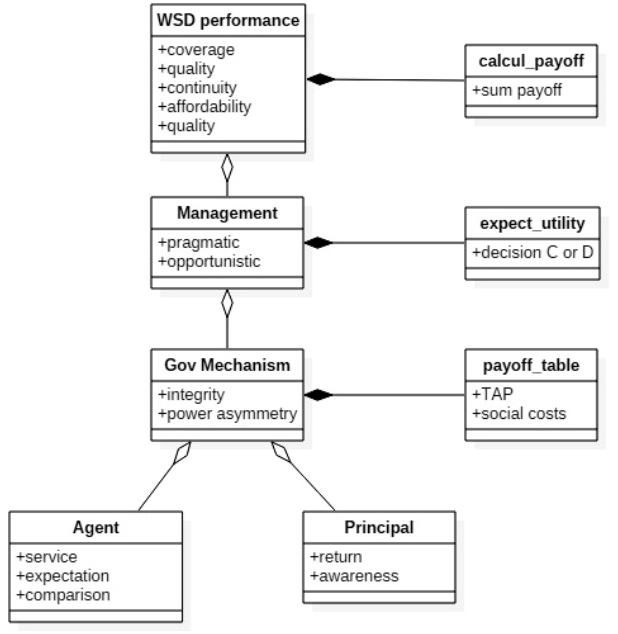
Fig. 3 . Class diagram. Note: WSD = water service delivery. TAP = transparency, acountability,